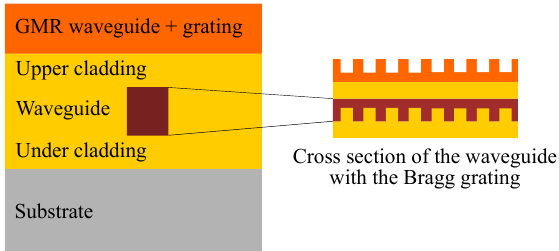
Figure 15. Schematic overview of the sensor with a waveguide Bragg and GMR grating on top of each other.